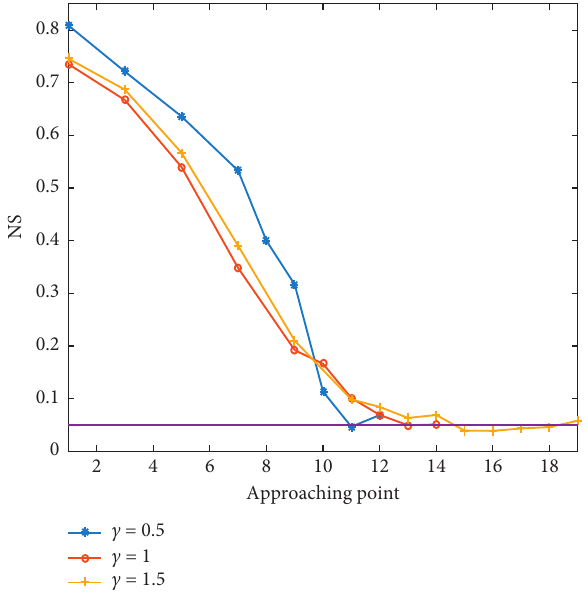
Figure 4: Calibration procedure for different noise